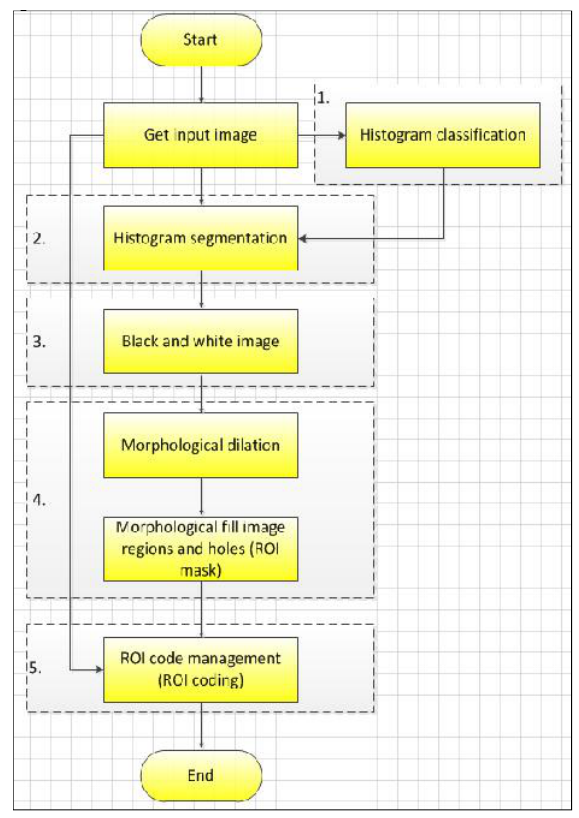
Figure 1. The propose algorithm for ROI automatic detection base on histogram segmentation.